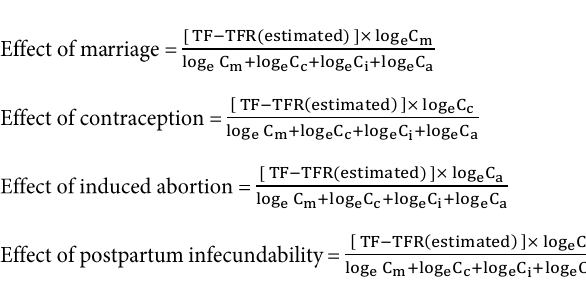
Table 1. Variations of the Proximate Determinants on Fertility Changes According to Selected Residence of Bangladesh: 1993-1994 to 2014 BDHS Residence and Survey Years